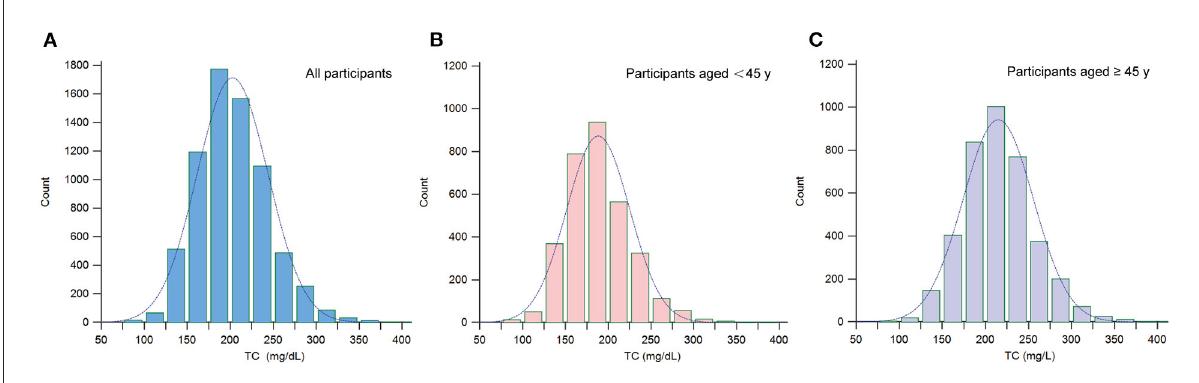
FIGURE2 Distribution histogram of serum TC. (A) Among all participants; (B) Among participants aged < 45; (C) Among participants aged ≥ 45. TC, total